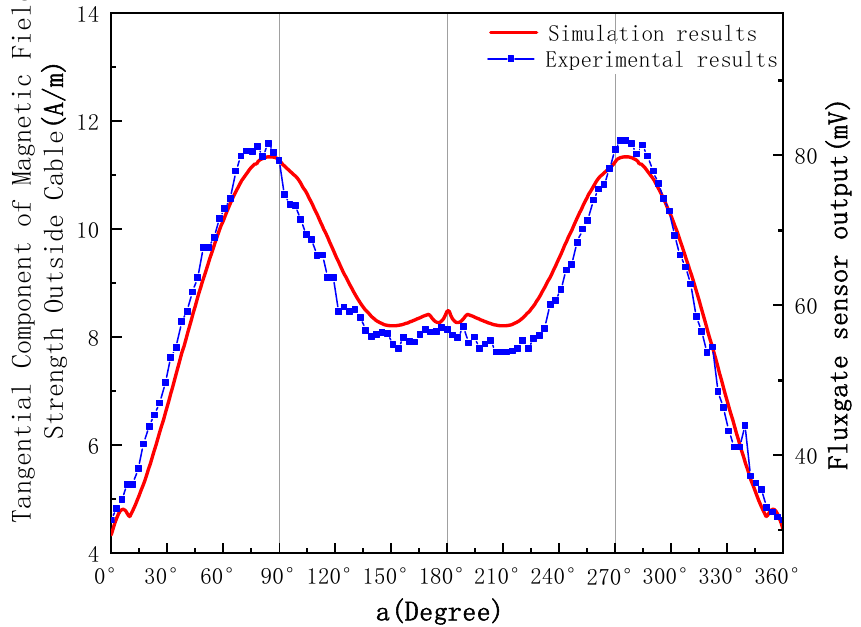
Figure 10. Comparison of experimental and simulation results of magnetic field distribution.